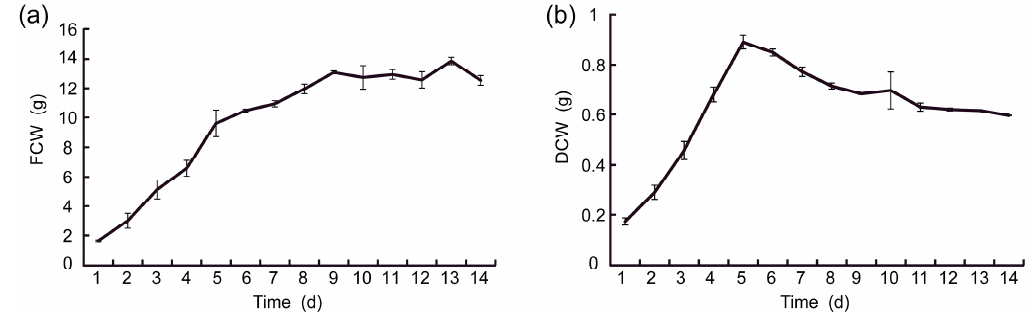
Figure 1. The growth curves of FCW and DCW of S. pohuashanensis suspension cell. FCW ( a ) and DCW ( b ) denote respectively the fresh cell weights and the dry cell weights of S. pohuashanensis suspension cell.